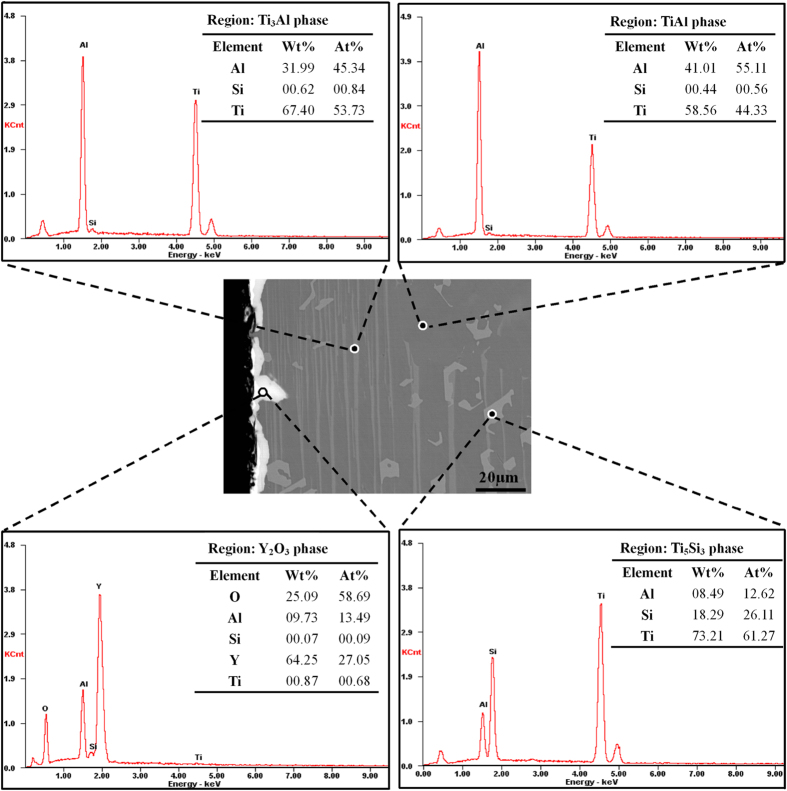
EDX spectrum of phases present near the surface of the Ti-43Al-3Si (at.%) specimen directionally solidified in a Y2O3-coated Al2O3 crucible.